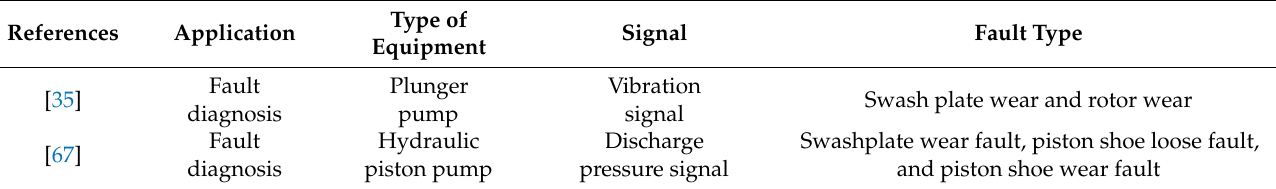
Table 8. Pump condition monitoring using empirical model